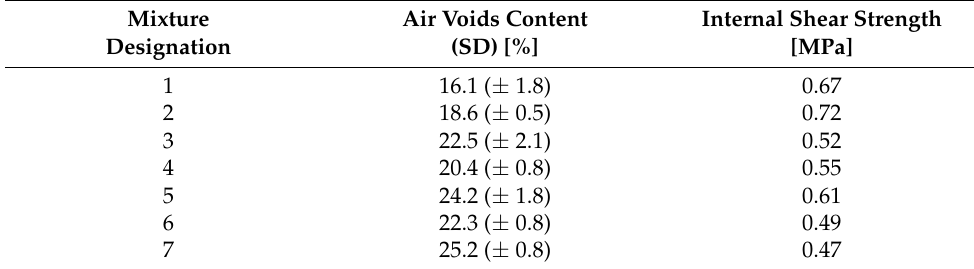
Table 2. Air void content and internal shear strength of the tested mixtures.